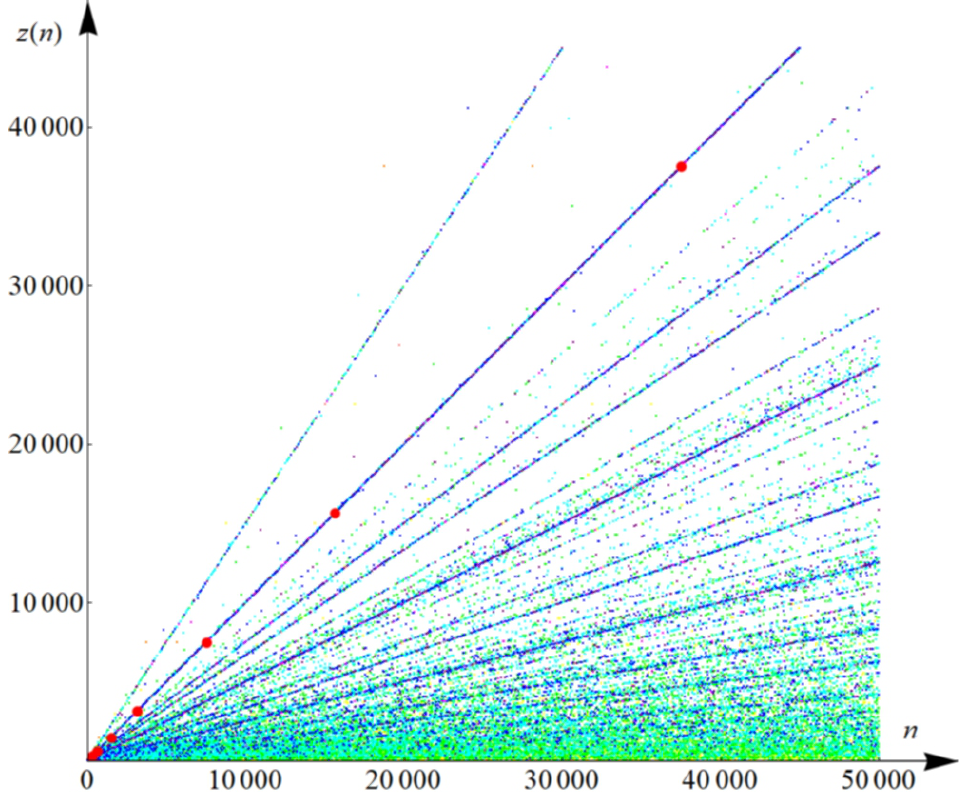
Figure 1. The scatterplot of z ( n ) for n from 1 to